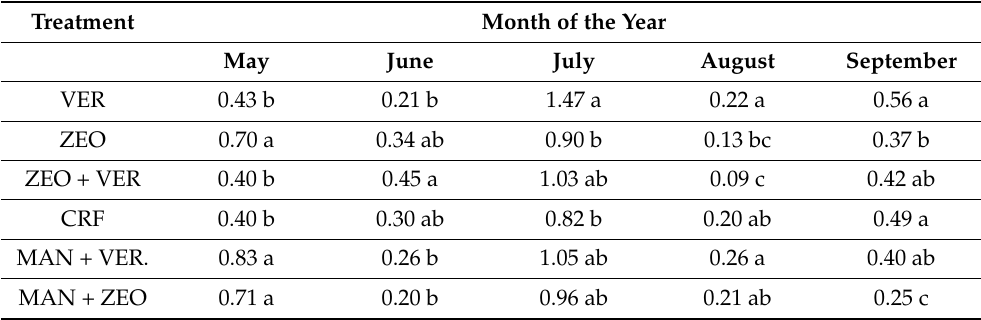
Table 2. Elongation rate (cm/day) of the main shoot of pepper plants during the 5 months of the